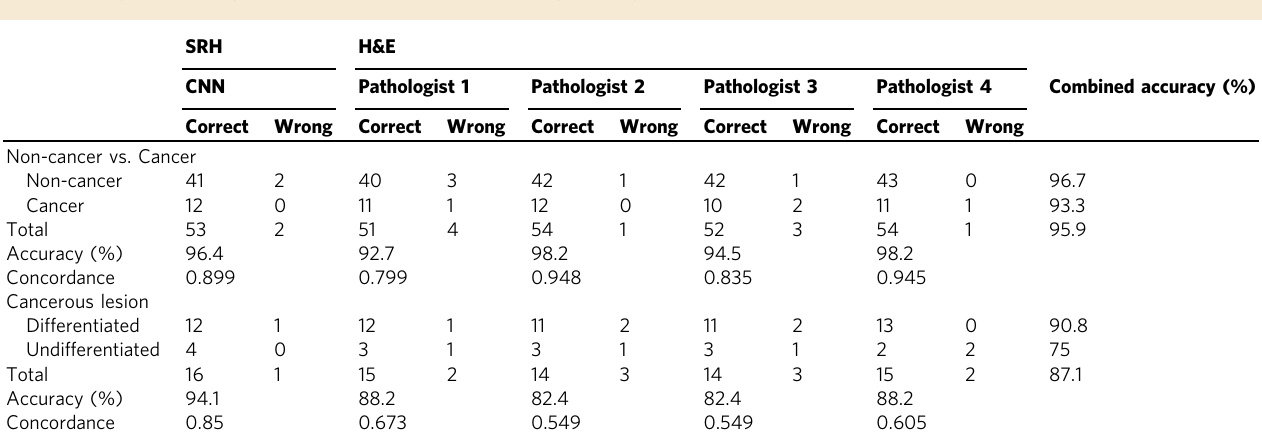
Table 1 Diagnostic comparison between femto-SRH and pathologists.